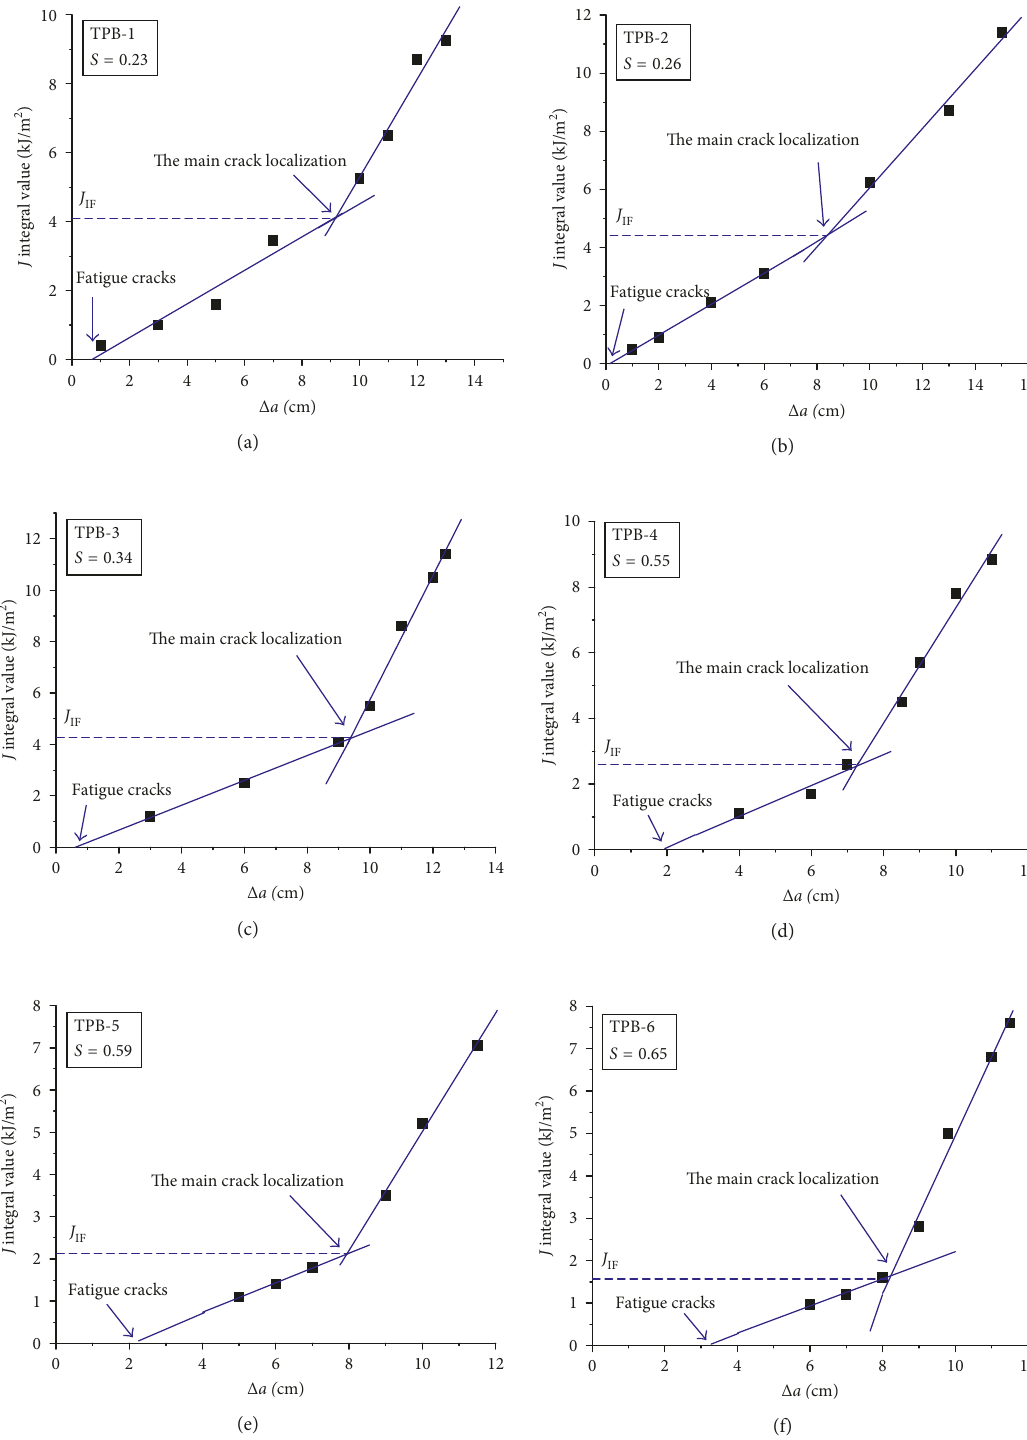
Figure 10: Relations between J integral and increment of the total crack